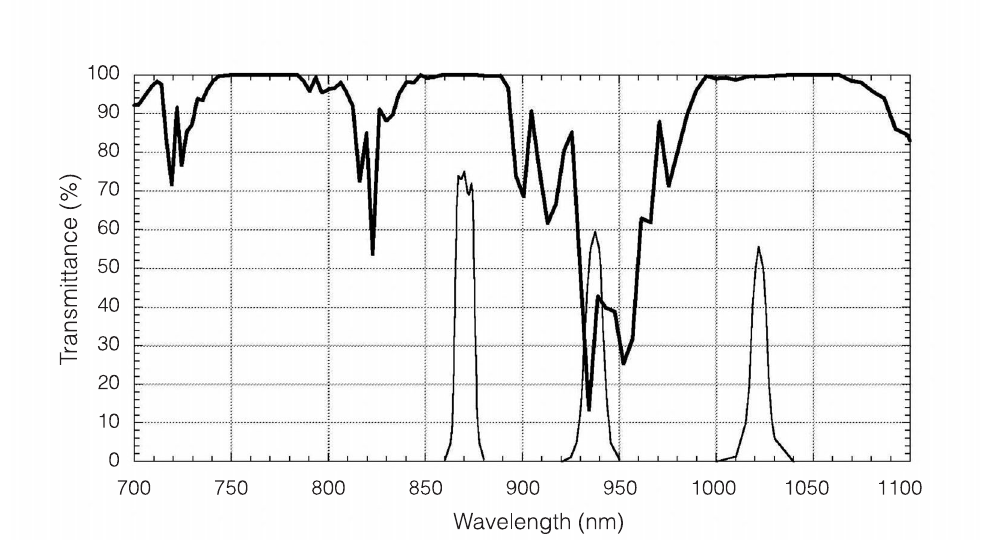
Fig. 1. MODTRAN midlatitude summer water vapour transmittance (thick line) and 870, 936, 1020 nm fi lter response functions (thin